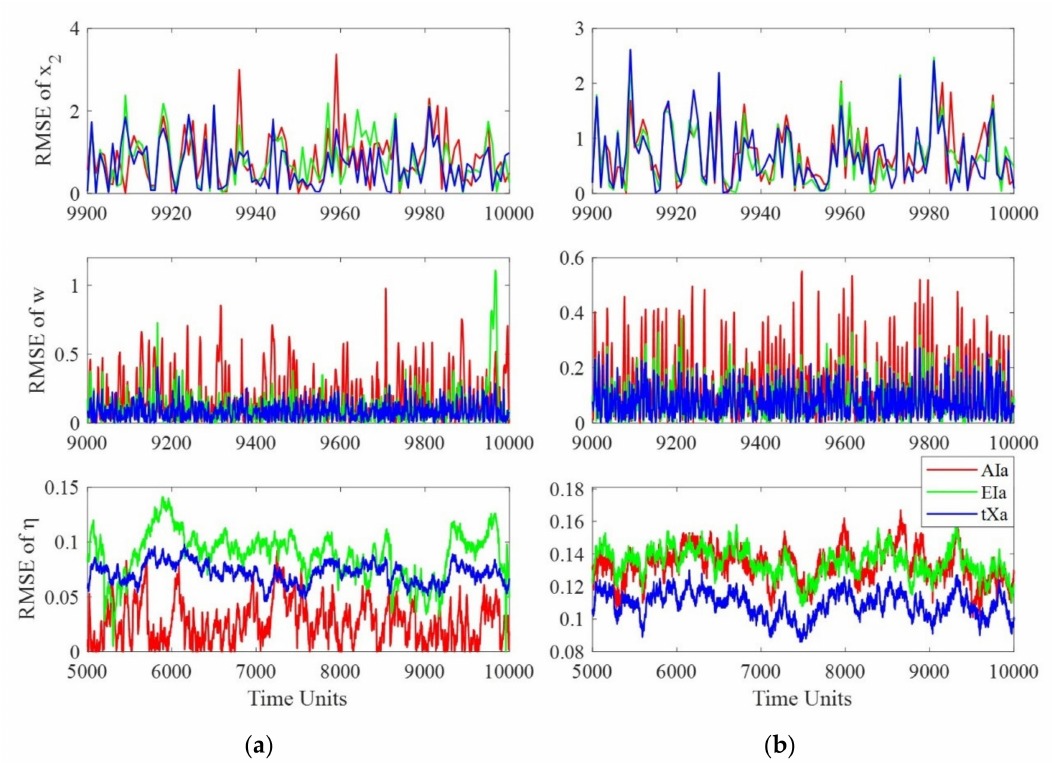
Figure 3. Time series of RMSEs of x 2 in the last 100 TUs, ω in the last 1000 TUs and η in 10,000 TUs in the imperfect model with AIa (red line), EIa (green line) and tXa (blue line), with an ensemble size of 5 for ( a ) and 20 for ( b